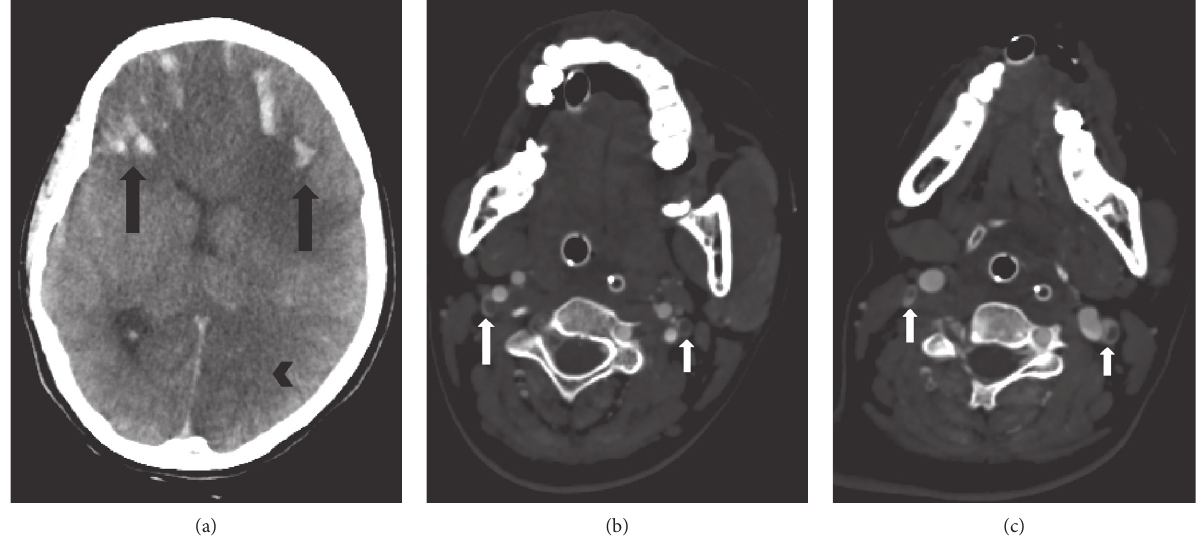
Figure 2: Follow-up contrast-enhanced CT brain and neck, indicating (a) haemorrhagic infarctions in both frontal lobes (black arrows); oedema in the left occipital lobe with loss of grey white demarcation (arrow head). (b, c) Contrast-enhanced CT brain and neck, showing filling defects in both internal jugular veins suggesting venous thrombosis (white arrows).